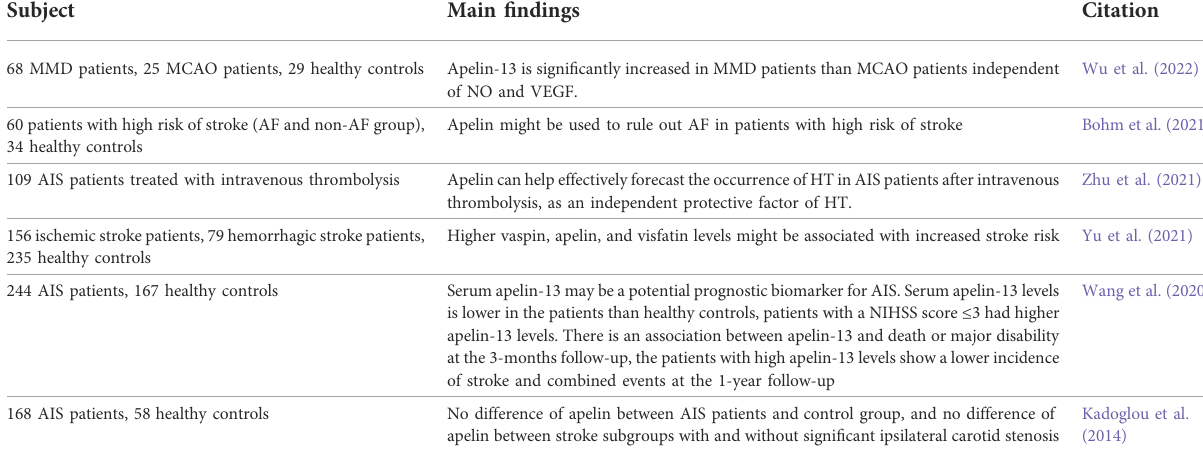
TABLE 1 The evidence from clinical trials demonstrating the role of apelin in